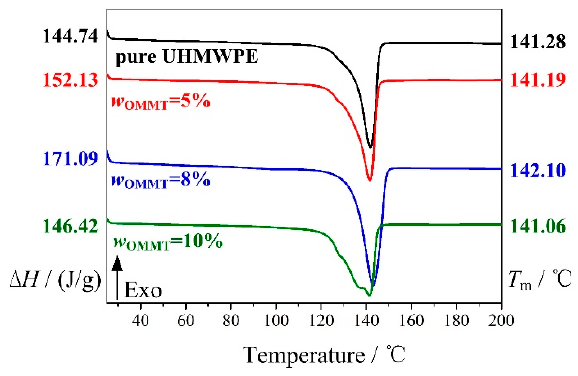
Figure 4. DSC curves of OMMT-modified UHMWPE under different addition amounts of OMMT.